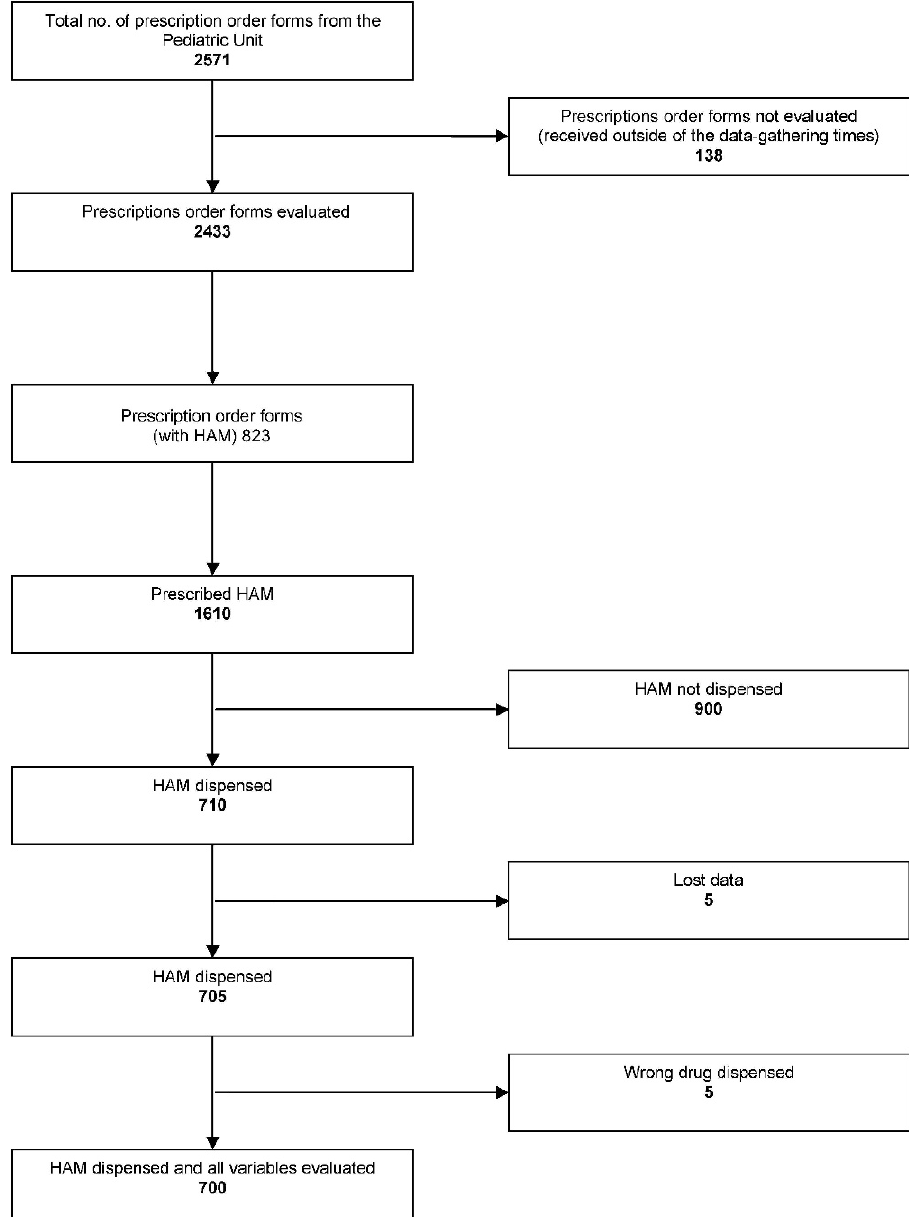
Figure 1 - A description of the selection process for prescriptions with high-alert